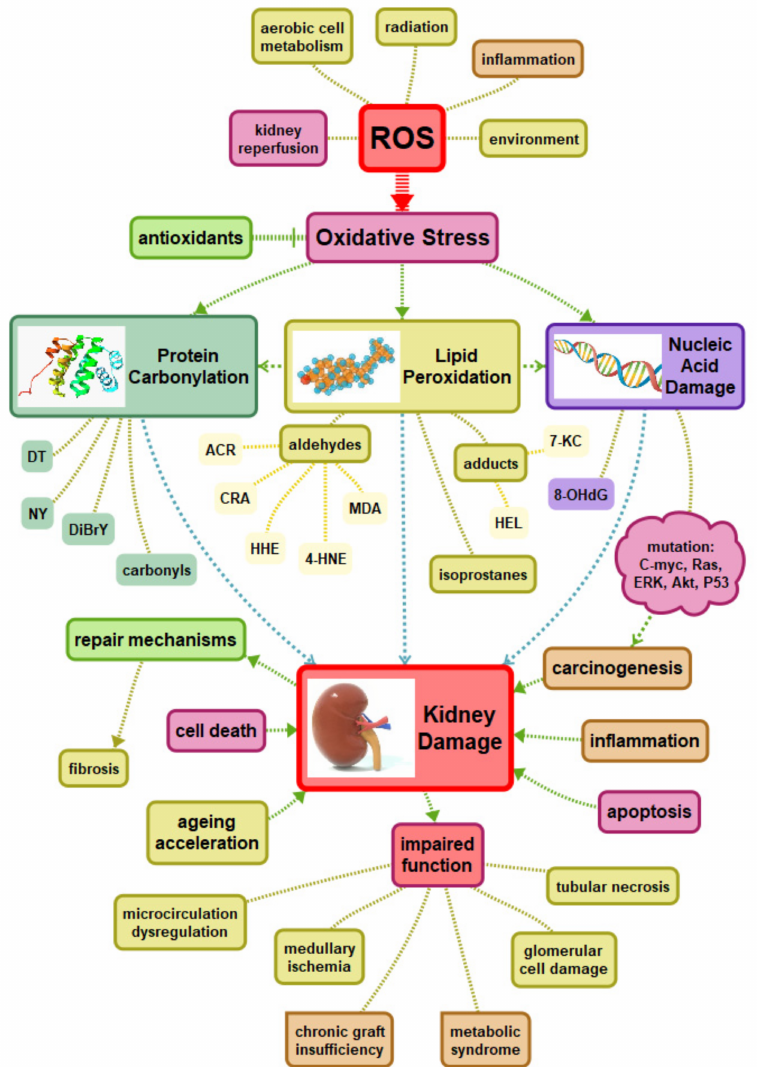
Figure 1. Oxidative stress and kidney damage. DT—tyrosine, NY—3-nitrotyrosine, DiBrY— dibromotyrosine, ACR—acrolein, CRA—crotonaldehyde, HHE—4-hydroxy-trans-2-hexenal, 4- HNE—4-hydroxynonenal, 7-KC—7-ketocholesterol, HEL—hexanoyl-lysine adduct, 8OHdG—8- hydroxy-2 (cid:48)